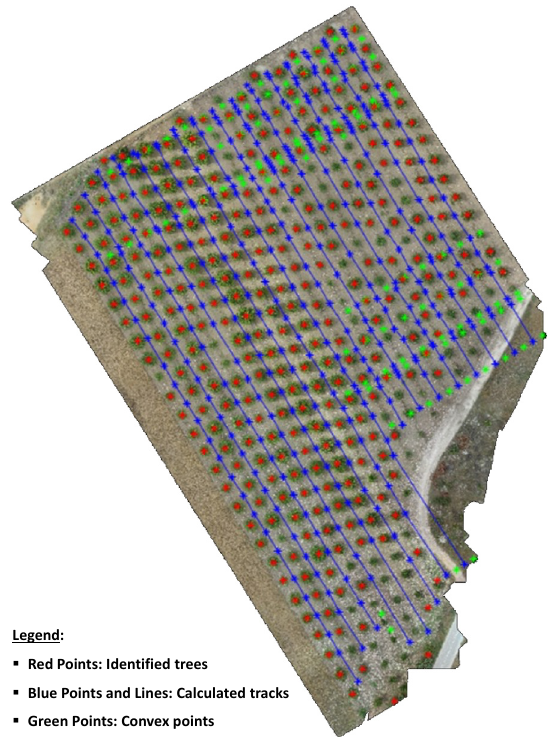
Figure 8. Extracted UGV tracks in the orchard.